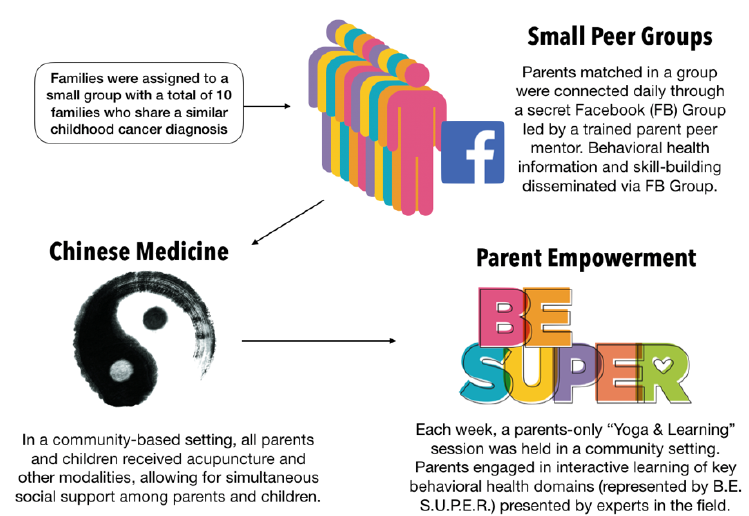
Figure 1. A visualization of the Ohana Project intervention structure.